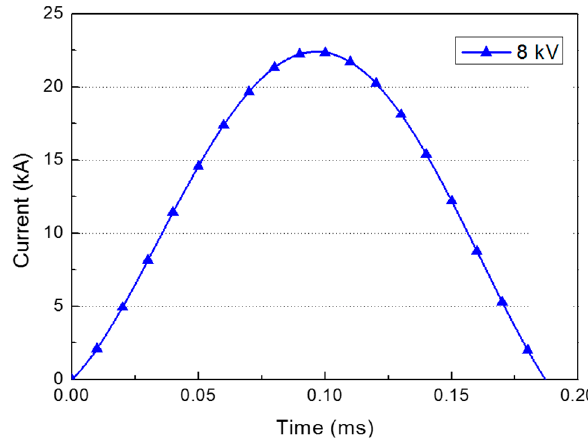
Figure 6. Current curve used in the numerical simulation.